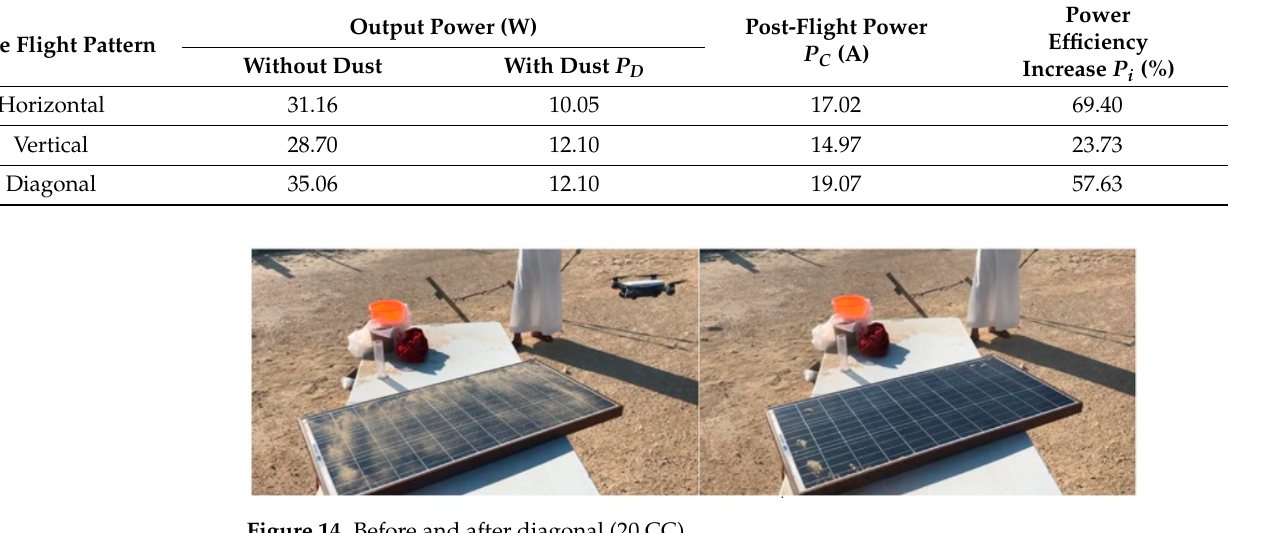
Figure 14. Before and after diagonal (20 CC). Table 4. Power analysis of different drone flight methods (50 CC).